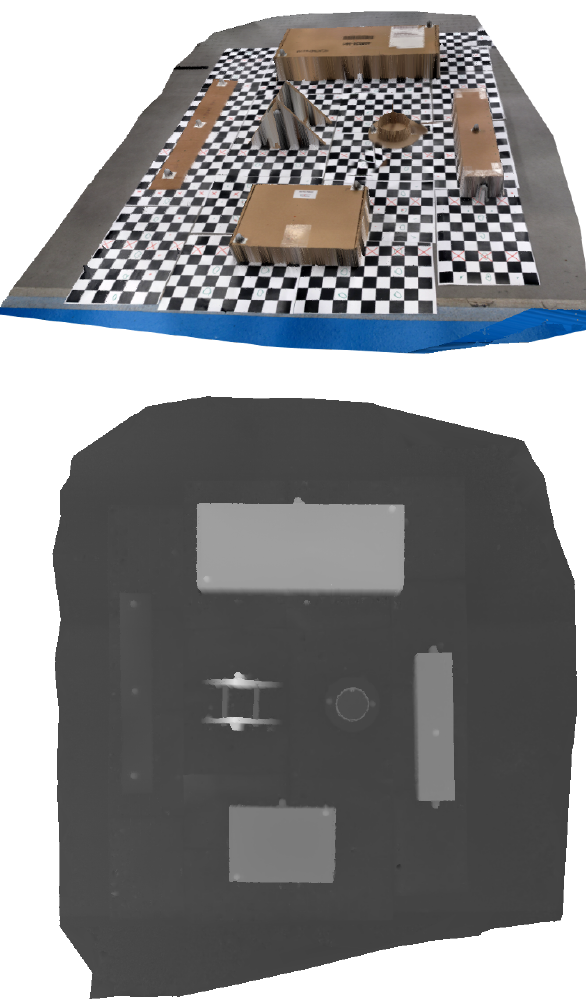
Figure 9: Scaled scenario and DEM generated during experi-